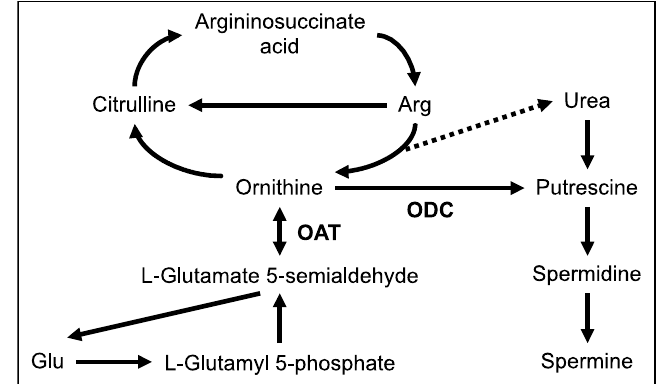
Figure 6. Image of ornithine metabolic pathways in the